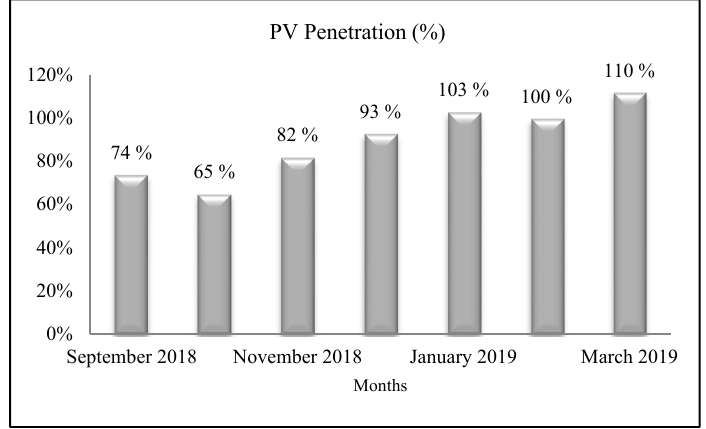
Figure 9. PV Penetration (%) of the months from September 2018 to March 2019.